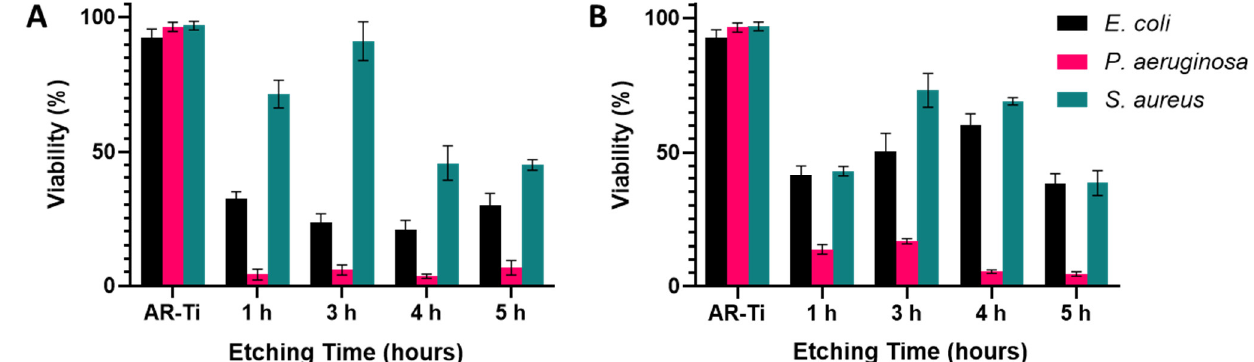
Figure 7. Percentages of viability observed across the three bacteria strains tested, after 20 h incubation on both NaOH-etched ( A ) and KOH-etched ( B ) for 1, 3, 4, and 5 h etching time, with initial seeding concentration of 10 6 CFUs (mean ± SD, n = 3).